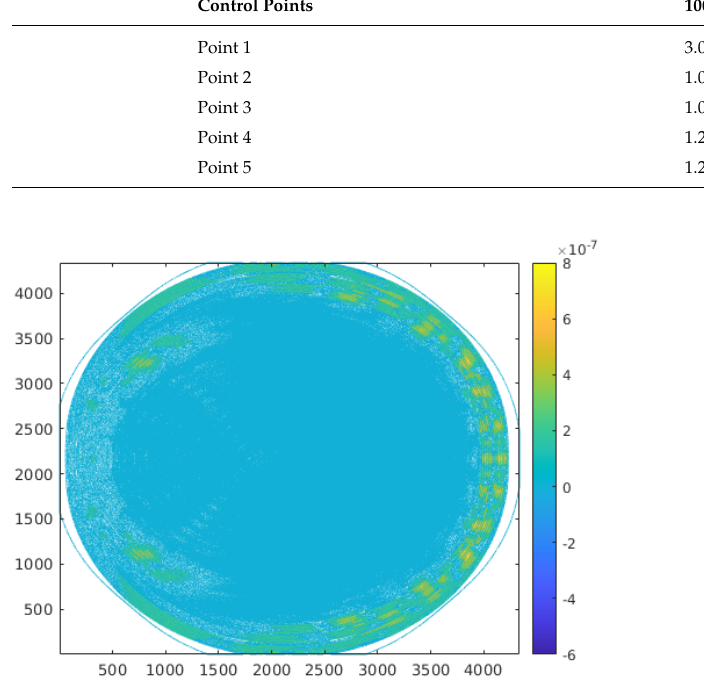
Figure 23. The absolute error between the CPU (double precision in serial mode) and the GPU (single precision) for the nanowaveguide